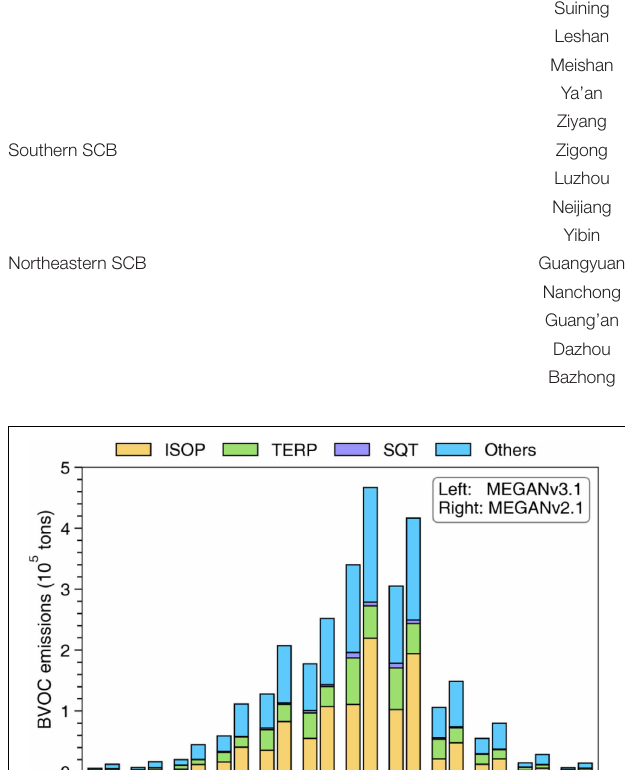
MEGANv3.1, respectively (as seen in Figure 2 ). By source